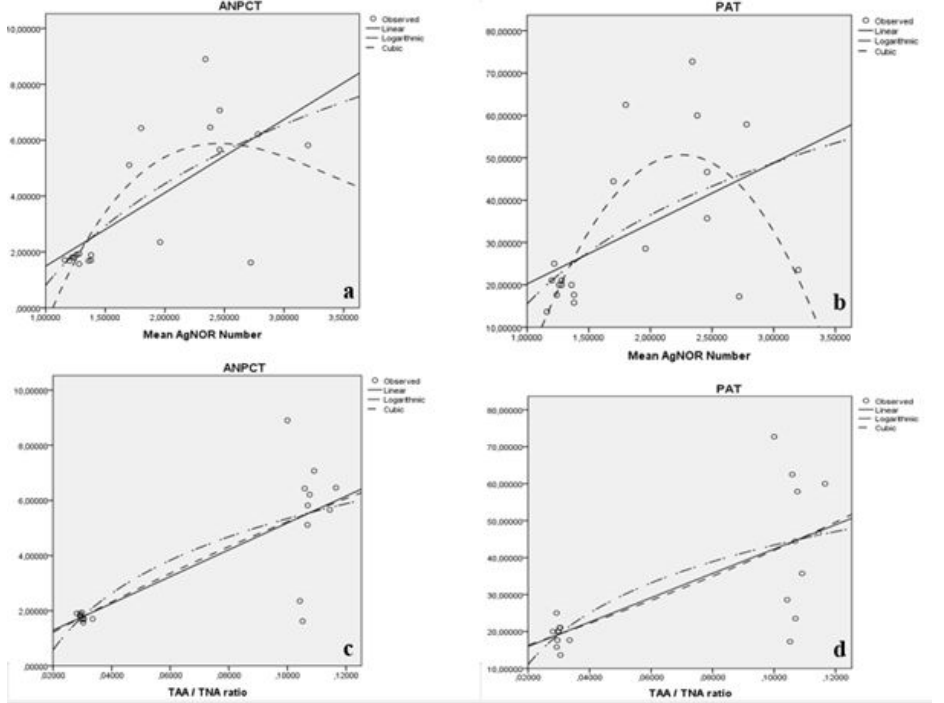
Figure 3. Relation between mean AgNOR numbers of testes cells and ANPCT ( a ), between mean AgNOR numbers of testes cells and PAT ( b ). Relation between mean TAA/TNA ratio of testes cells and ANPCT ( c ) and between TAA/TNA ratio of testes cells and PAT ( d ). Representative images of silver stained NOR (a: Control, b: Sham, c: Late T/D, d: Early T/D for testicular cells were given in the Figure 4.